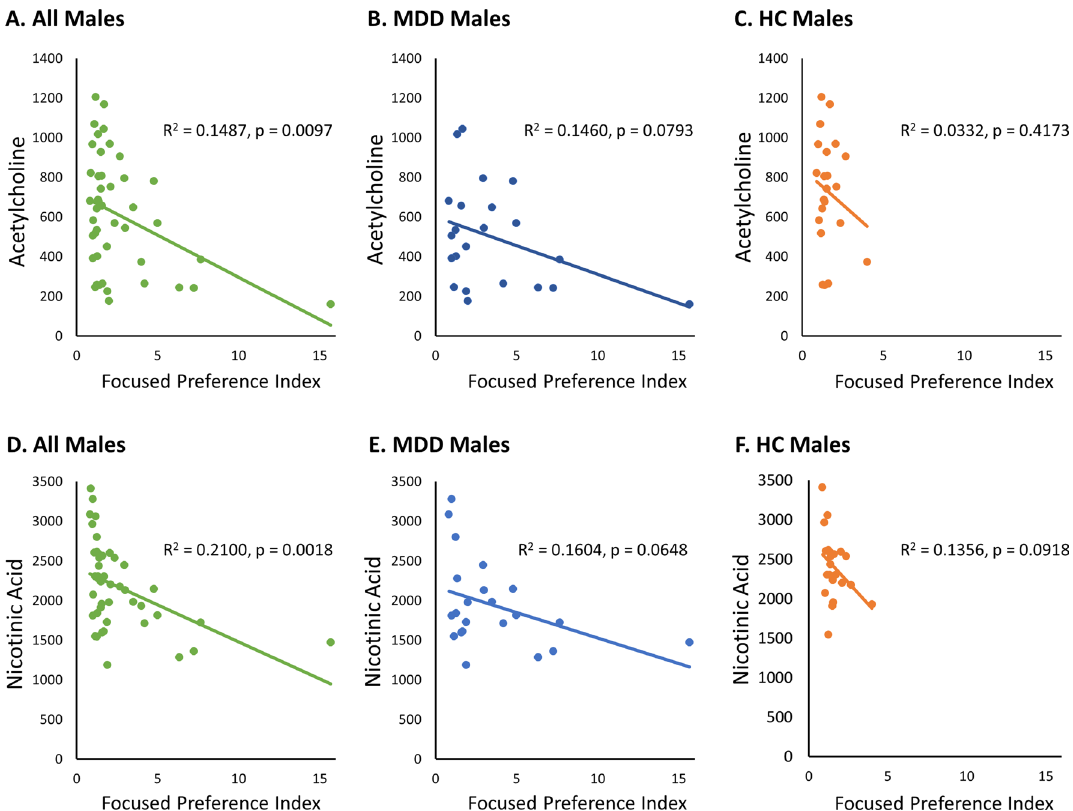
Figure 2. Correlation of biomarker with focused preference index in males. Scatter plot showing negative correlation of focused preference index between plasma acetylcholine ( A – C ) and nicotinic acid ( D – F ) in MDD and HC males. Linear regression lines with dot plots showing relationship between focused preference index and ( A ) acetylcholine among all males (N = 44), ( B ) acetylcholine among MDD males (N = 22), ( C ) acetylcholine among HC males, ( D ) nicotinic acid among all males (N = 44), ( E ) nicotinic acid among MDD males (N = 22), and ( F ) nicotinic acid among HC males (N = 22). MDD major depressive disorder, HC healthy